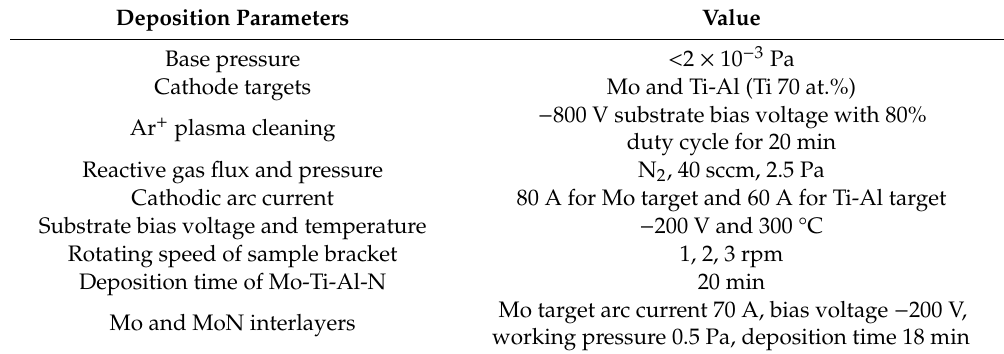
Table 1. Deposition parameters of Mo-Ti-Al-N composite